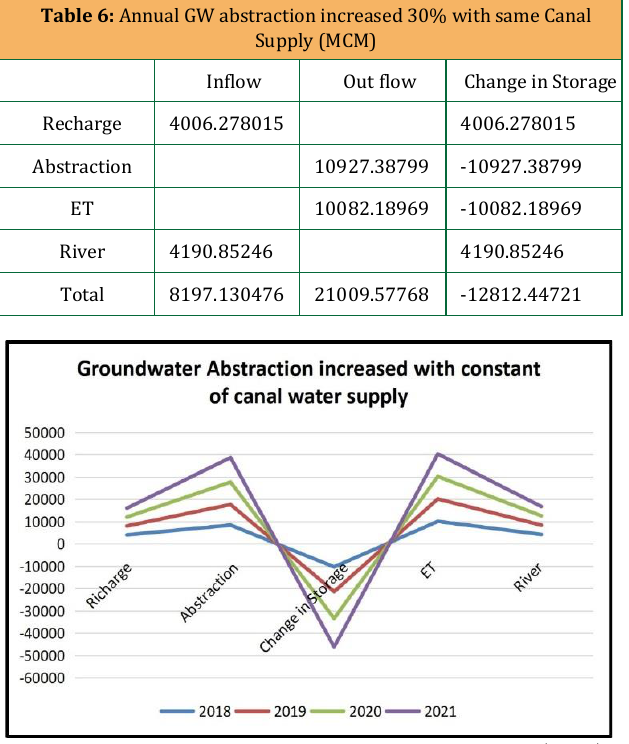
Figure 7: GW Abstraction increased with the Canal water supply (MCM)